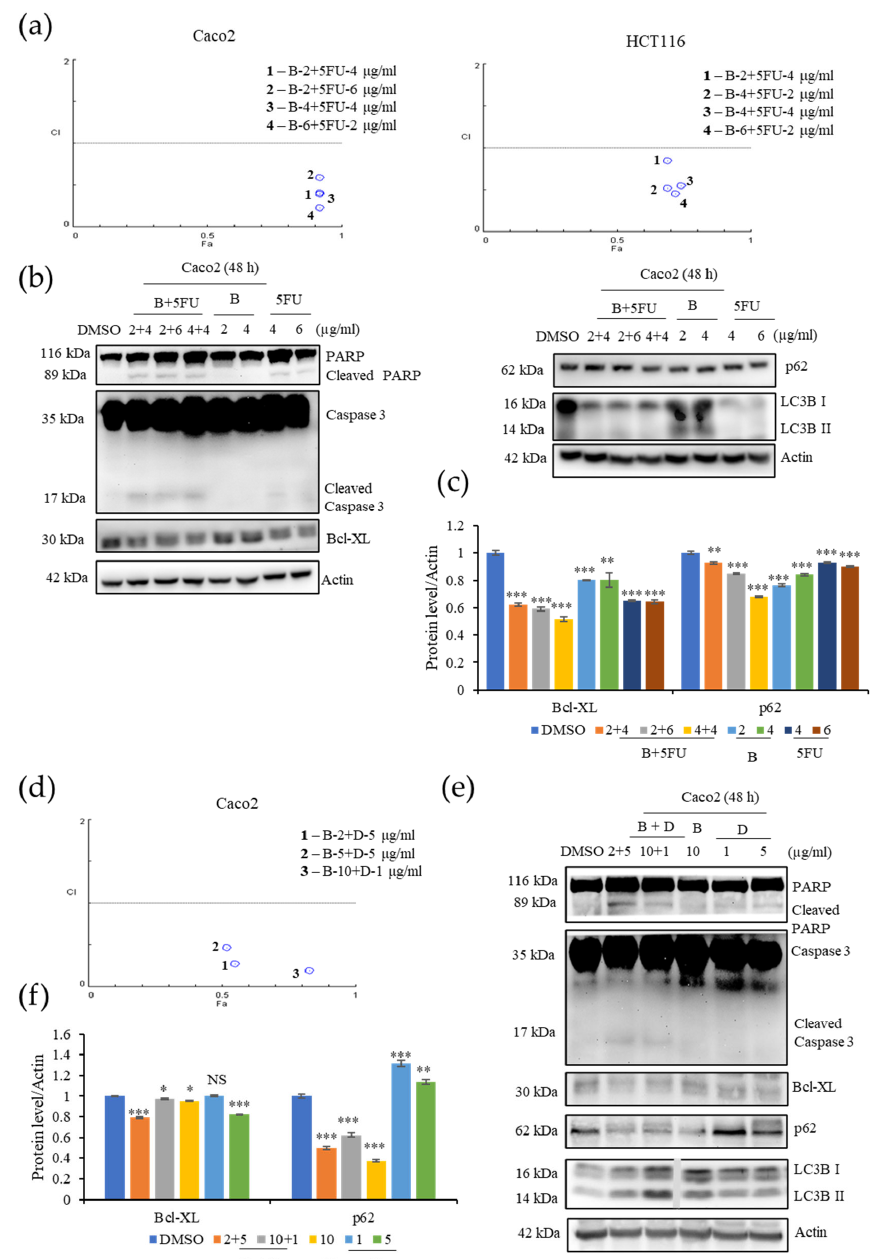
Figure 7. B shows synergy with 5-FU and with D, a compound isolated from the crude extract of EL000327 on the CRC cells. ( a ) Fa-CI plot of combination treatment with 5-FU (2, 4 or 6 µ g/mL) and B (2, 4 or 6 µ g/mL) on the Caco2 cells and the Fa-CI plot of combination treatment with 5-FU (2 or 4 µ g/mL) and B (2, 4 or 6 µ g/mL) on the HCT116 cells. ( b ) Expression of apoptosis and autophagy related protein in Caco2 cells after combination treatment with 5-FU (4 or 6 µ g/mL) and B (2 or 4 µ g/mL) or B (2 or 4 µ g/mL) or 5FU (4 or 6 µ g/mL) individually for 48 h, as detected by Western blotting. ( c ) Quantification of Bcl-XL and p62 protein expression after the treatment with B +5FU or B or 5FU at the indicated concentrations. ( d ) Fa-CI plot of combination treatment with D (5 or 1 µ g/mL) and B (2, 5 or 10 µ g/mL) on the Caco2 cells. ( e ) Western blot analysis of apoptosis and autophagy related protein expression in the Caco2 cells after combination treatment with D (5 or 1 µ g/mL) and B (2 or10 µ g/mL) or B (10 µ g/mL) or D (1 or 5 µ g/mL) individually for 48 h. ( e ) Quantification of Bcl-XL and p62 protein expression after the treatment with B + D or B or D at the indicated concentrations. Data represent the mean ± S.D. * p < 0.05, ** p < 0.01, *** p < 0.001; NS: no significant difference ( p > 0.05) compared with the NAC-treated group or the DMSO-treated